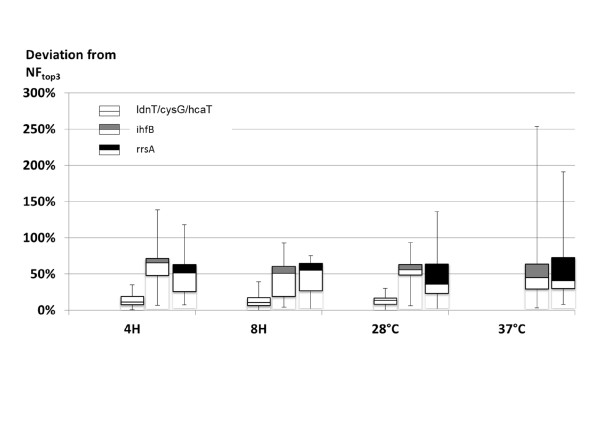
Comparison of the normalization factors calculated using different reference gene(s) in E. Coli BL21 (DE3). Normalization factors (NFs) calculated with idnT/cysG/hcaT, rrsA and ihfB were compared to that calculated by the top 3 reference genes (NFtop3) as recommended by both NormFinder and geNorm, for each stimulus. The percentage deviations of NFldnT/cysG/hcaT; NFrrsA; NFihfB from NFtop3 (|NFx-NFtop3|/NFtop3) were represented by box plot. The 25th percentile to the 75th percentile (boxes), and ranges (whiskers) were shown.